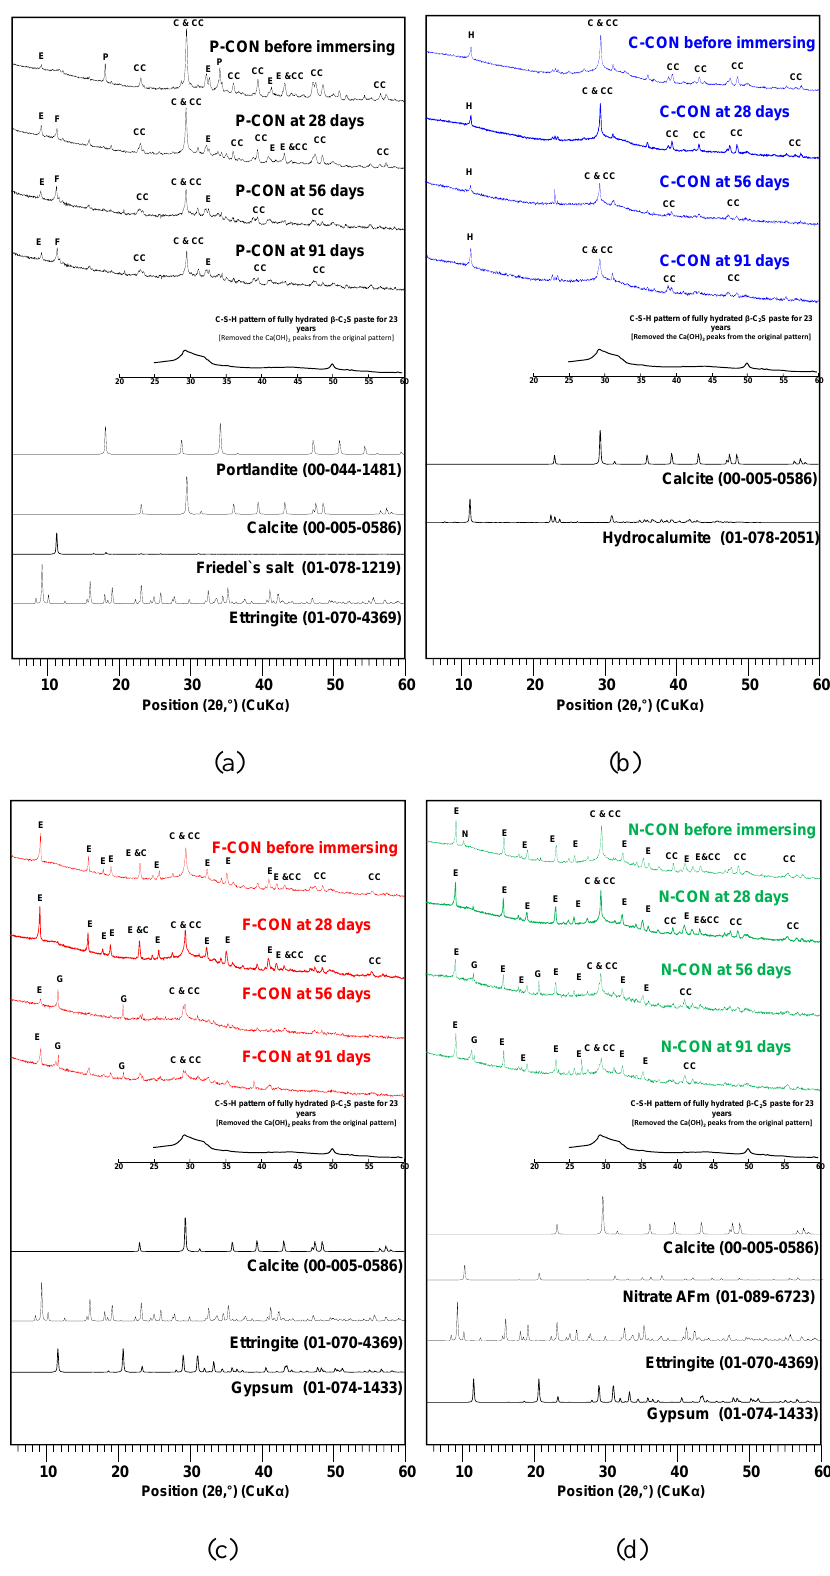
Figure 8. XRD patterns of hardened samples immersed in 5% HCl solution: ( a ) P-CON, ( b ) C-CON, ( c ) F-CON, and ( d ) N-CON. (Note. E: ettringite, C: C-S-H, CC: calcite, G: gypsum, H: hydrocalumite, F: Friedel’s salt, P: portlandite, and N: nitrate AFm,